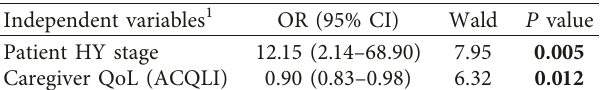
Table 5: Multivariable logistic regression model of associations with informal caregivers’ satisfaction with support (not sat- isfied � 0; satisfied � 1), n � 68.